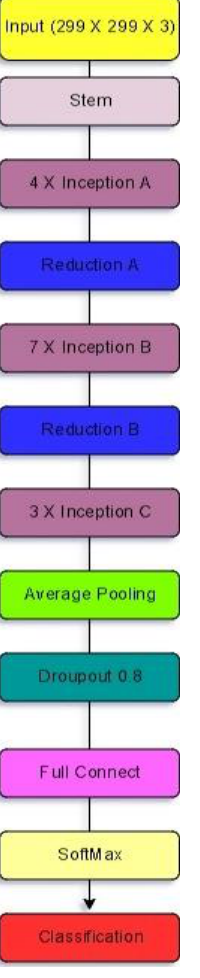
Figure 4. Details of Inception V4 architecture with ( a – c ) layers.